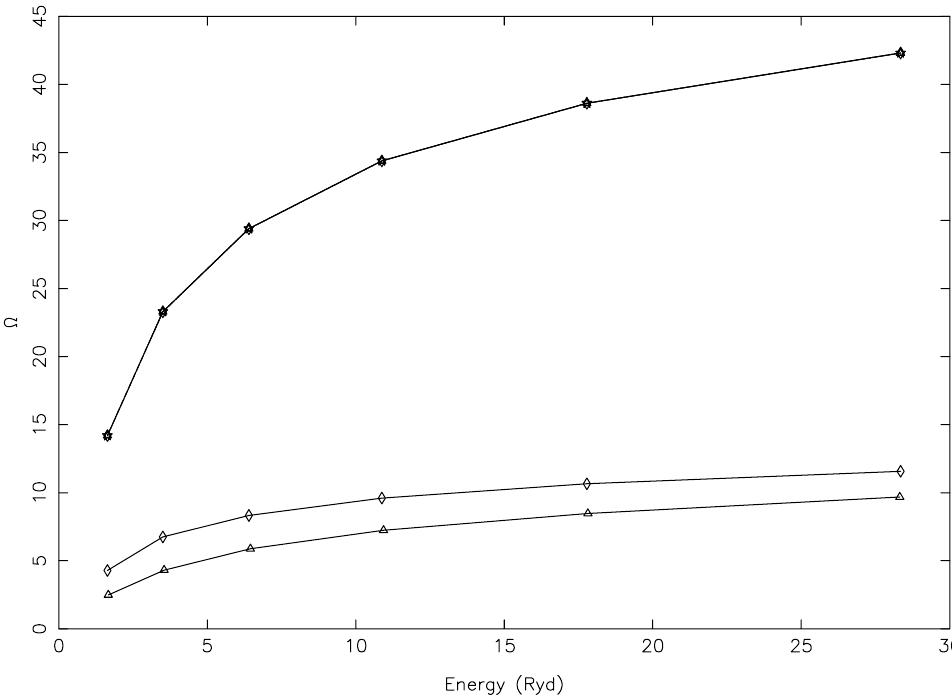
Figure 9. Our calculated values of Ω with FAC for the 13–32 (triangles: 3p3d 1 D o (diamonds: 3p3d 3 P o –3p4p 3 D 1 ), and 22–33 (stars: 3p4s 3 P o 1